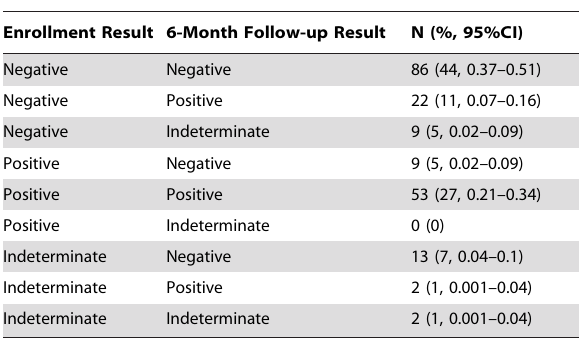
Table 4. Agreement of enrollment and 6 month follow-up results by QFT-GIT–N